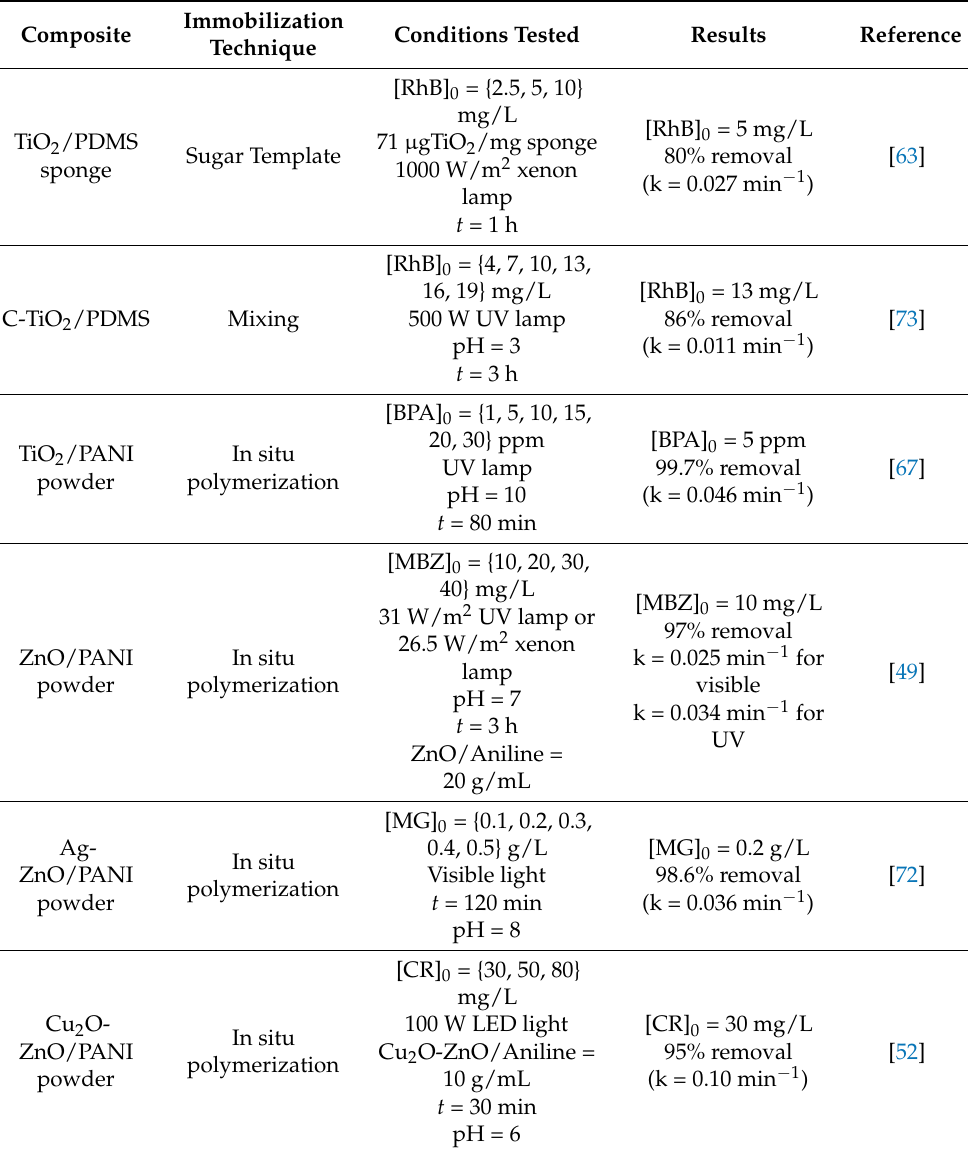
Table 5. Summary of studies that have analyzed the effect of the composite load on the polymer- supported photocatalysis